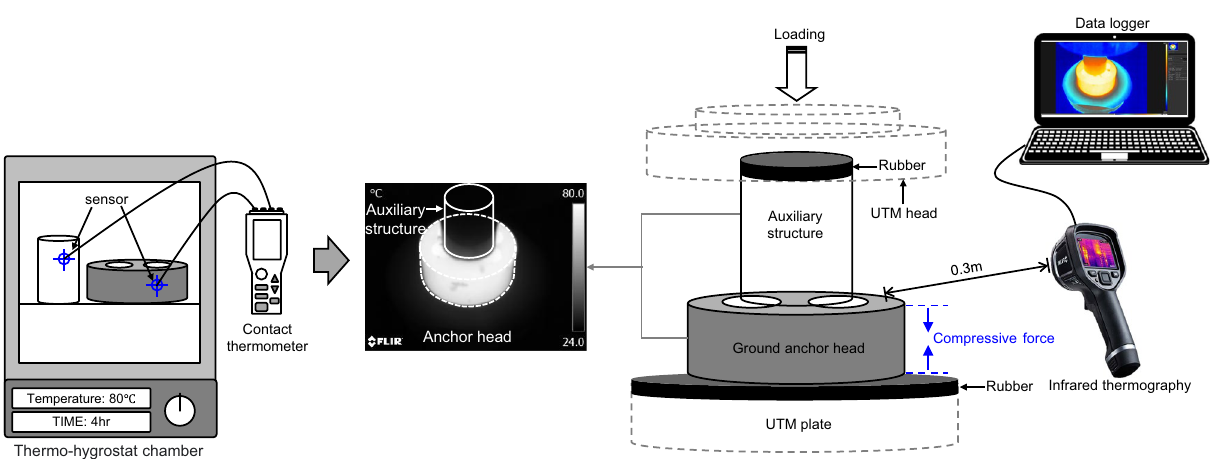
Figure 4. Schematic description for performing the active method using a heated anchor head and universal test machine